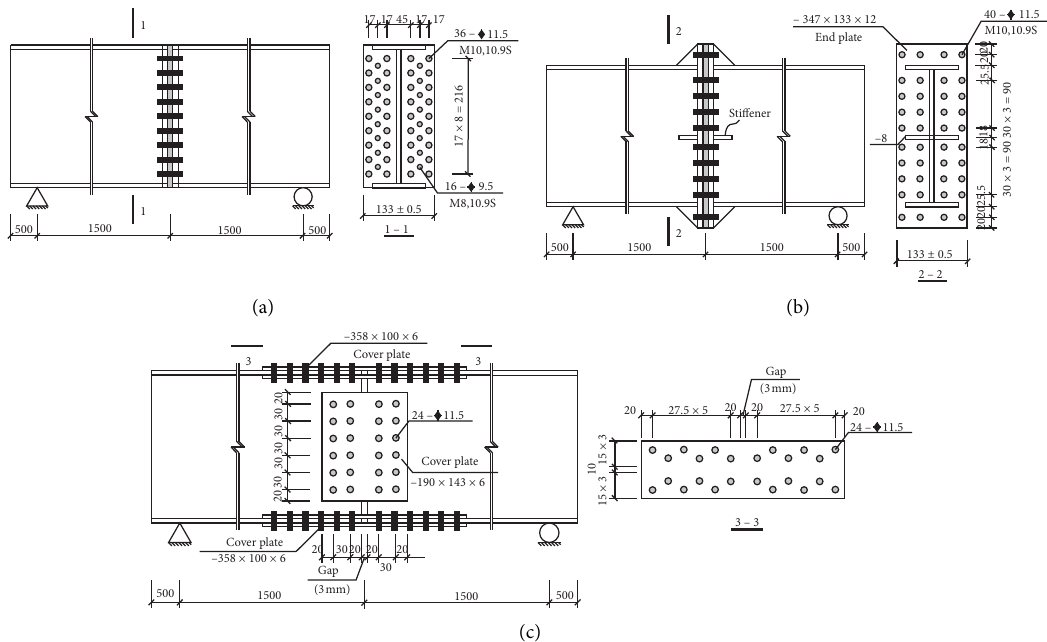
Figure 3: Details of specimens. (a) FLB specimens. (b) EPB specimens. (c) CPB